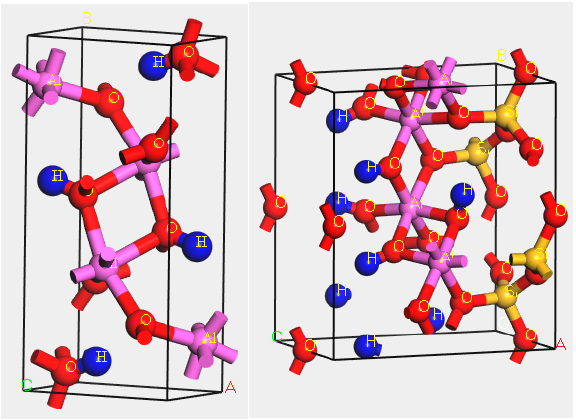
Figure 1. The molecular model of diaspore ( left ) and kaolinite ( right ).